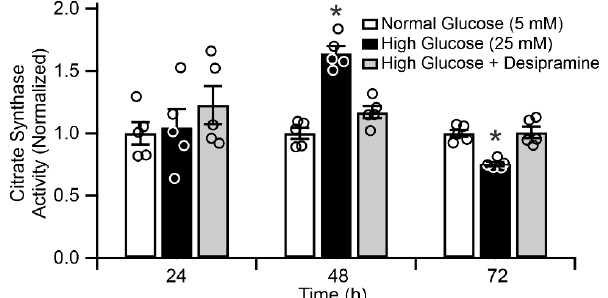
Figure 6. Citrate synthase activity in ARPE-19 cells. White bars = control cells, black bars = 25 mM glucose-treated cells, gray bars = 25 mM glucose-treated cells with daily 1 h treatment with 15 μ M desipramine. * p < 0.05, n = 5.